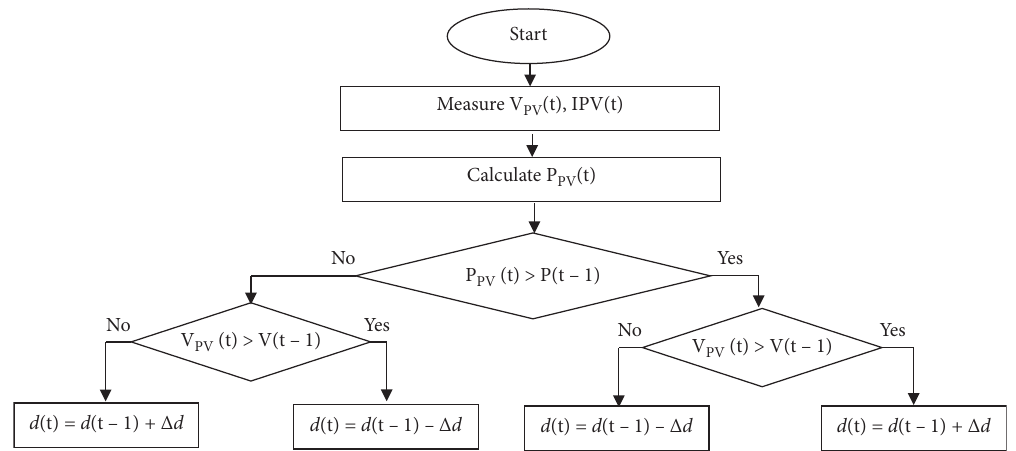
Figure 11: Flowchart of the P&O algorithm.